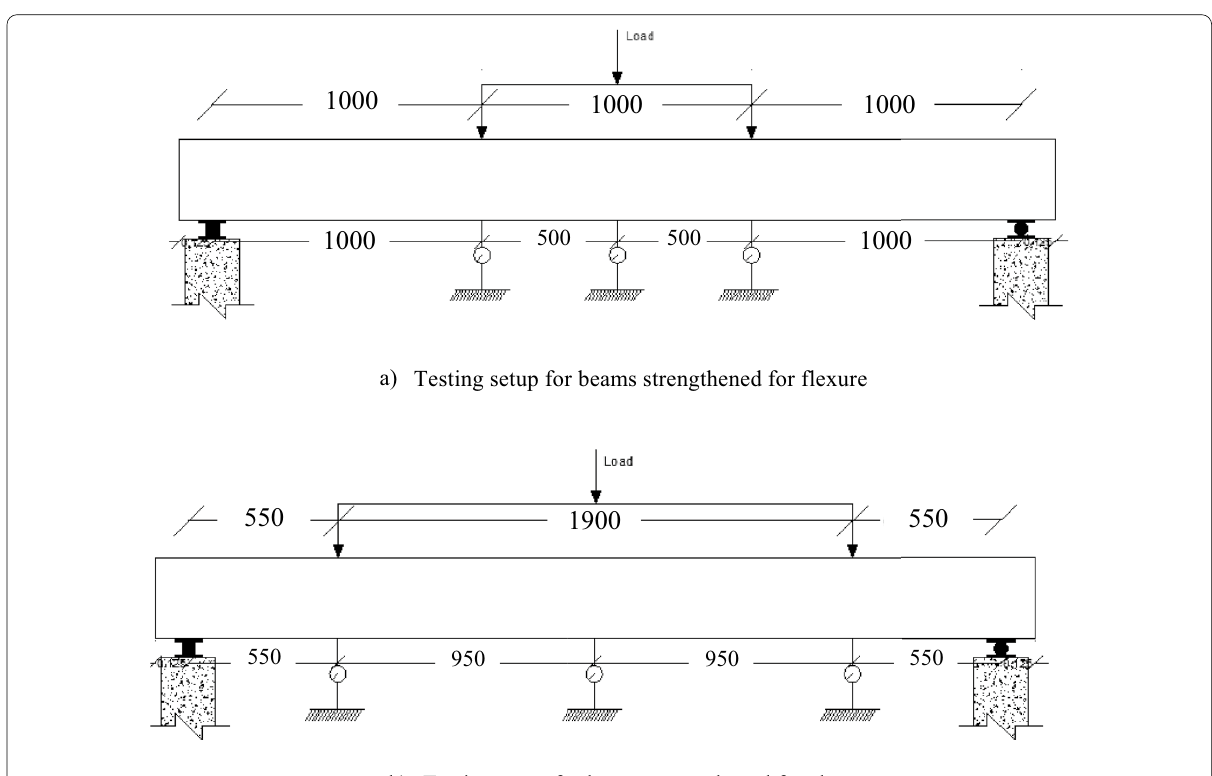
Fig. 8 LVDT arrangement for deflection measurements in studied beams.